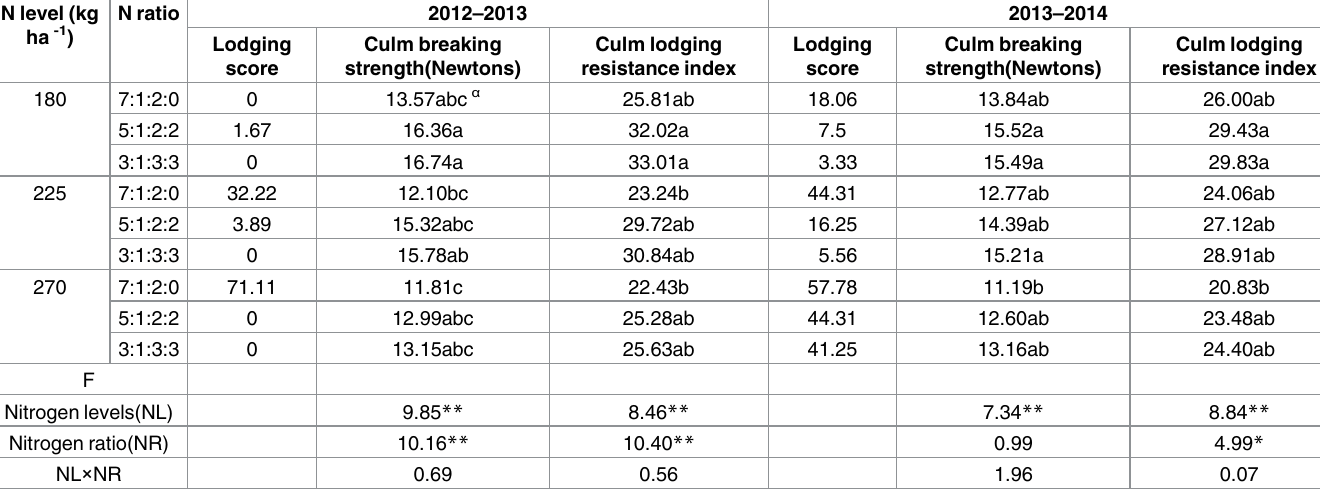
Table 2. Effect of nitrogen levels and ratios on culm breaking strength and culm lodging resistanceindex. N level (kg N ha -1 )